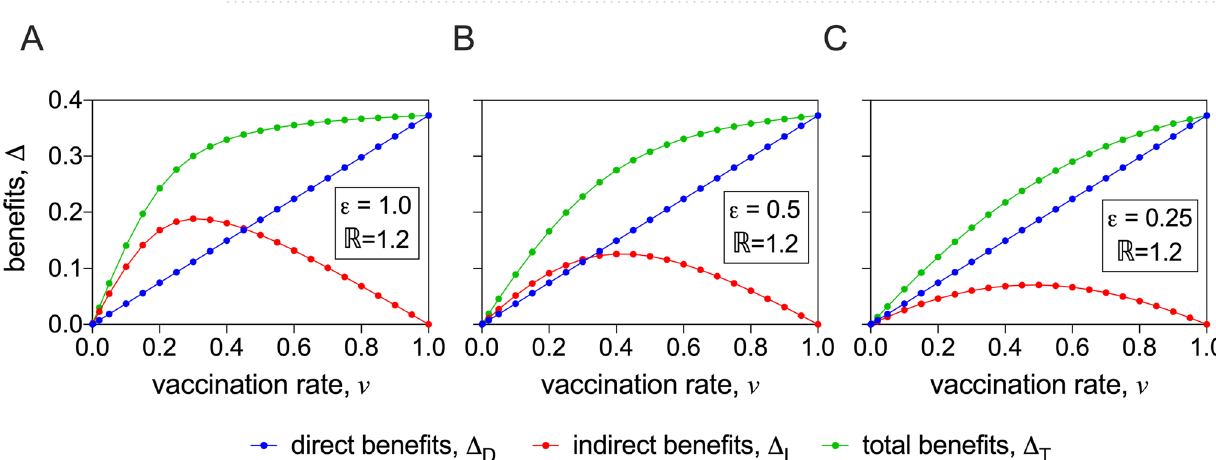
Figure 3. Benefits of vaccination. The direct, indirect and total benefits are plotted as functions of the vaccination rate v . The basic reproduction number has been set to R = 1.2 , but the vaccine effectiveness, ε , has been set to the values 1.0, 0.5, and 0.25 in Panels ( A – C ),